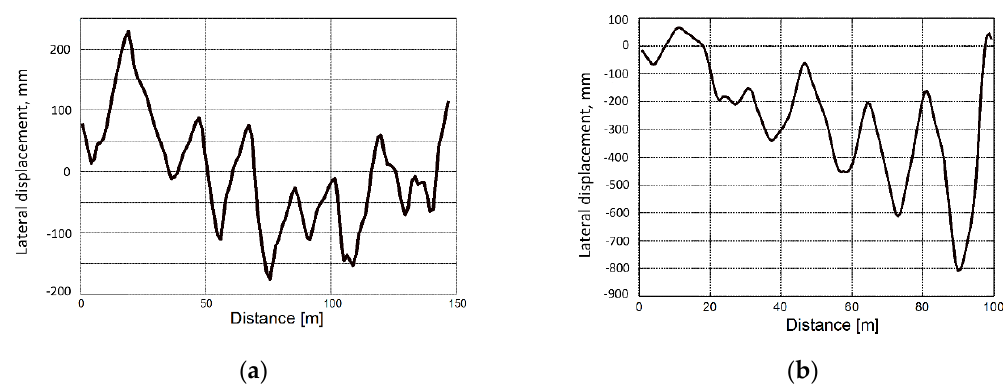
Figure 2. Example of driver lateral displacement during straight-line riding at 30 km/h speed—( a ) hydraulic steering system with mechanical feedback and ( b ) hydraulic steering system with load-sensing system (LS) and hydraulic amplifier.